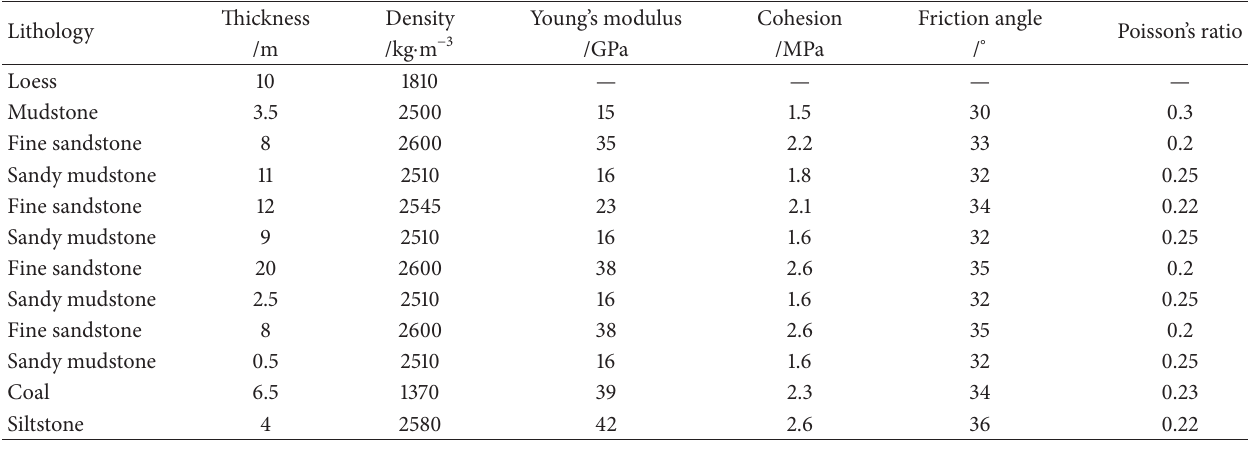
Figure 1: The abnormal phenomena in underground mining under gullies. (a) Pillar gets inclined and spalls; (b) slope rock is broken and bare. Table 1: Key properties of the overlying rock.